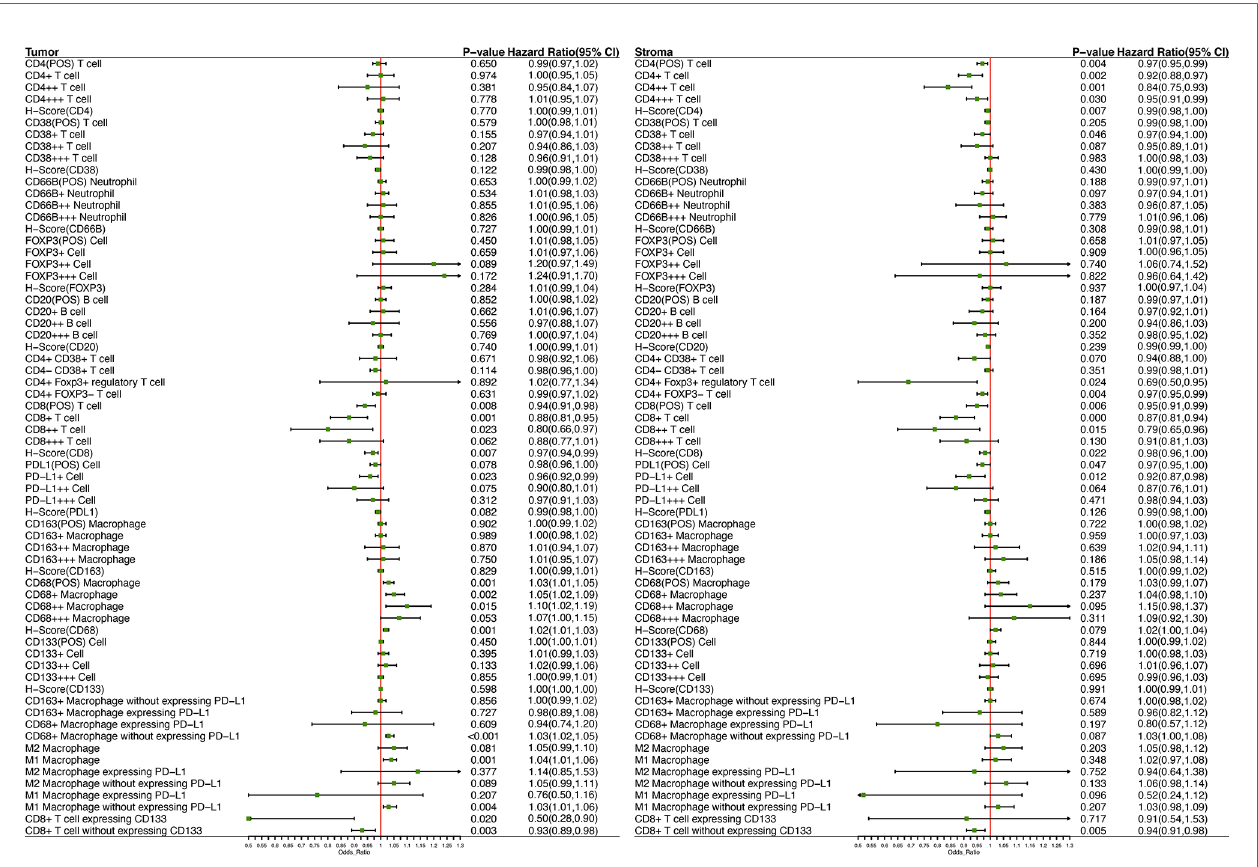
FIGURE 5 | Forest plot demonstrates the prognostic signi fi cance of diverse immune biomarkers in the tumor nest and tumor stroma as implemented in the multivariable Cox analysis with age, sex, T stage, N stage, vascular cancer embolus, and the number of lymph node resections as